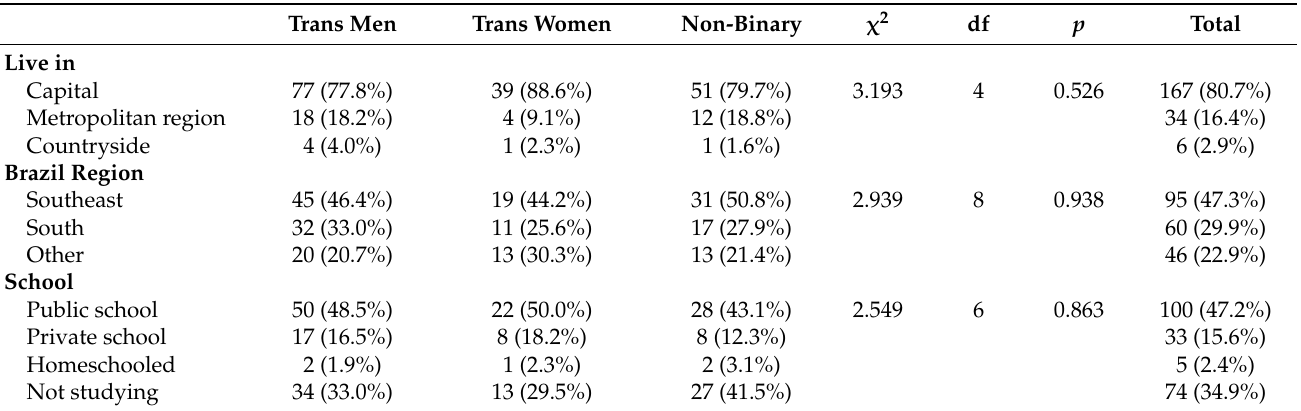
Table 1. Sample description by